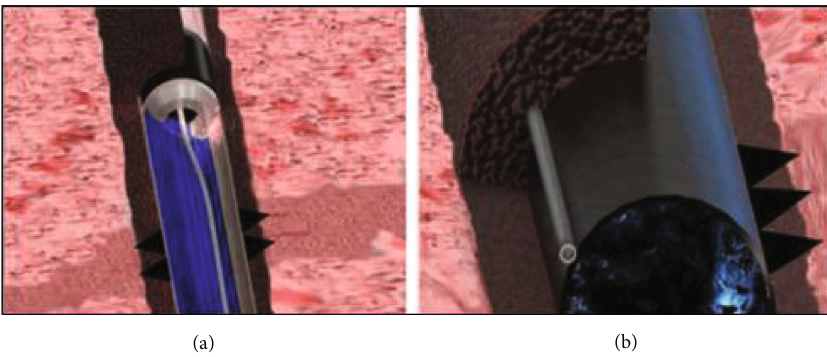
Figure 2: Installation of the optical cable (a) along the fl ow path (b) and behind the casing modi fi ed after [31].